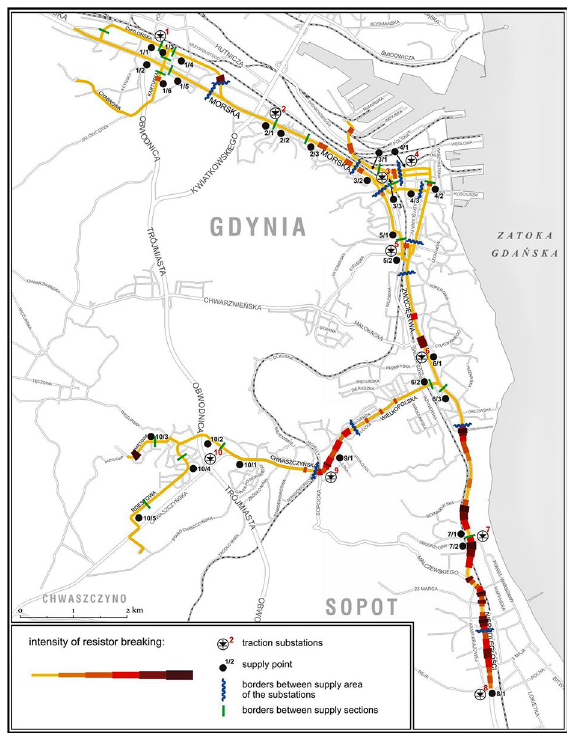
Fig. 16. Resistor braking intensity map – winter